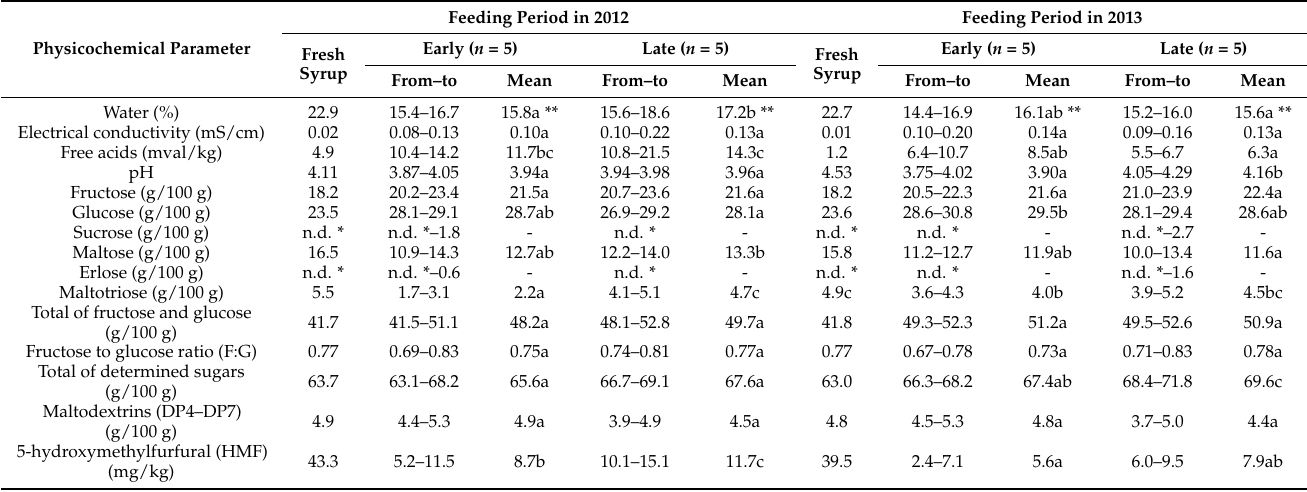
Table 1. Physicochemical composition of winter stores produced by bees fed with starch syrup I (Apifortune). Feeding Period in 2012 Physicochemical Parameter